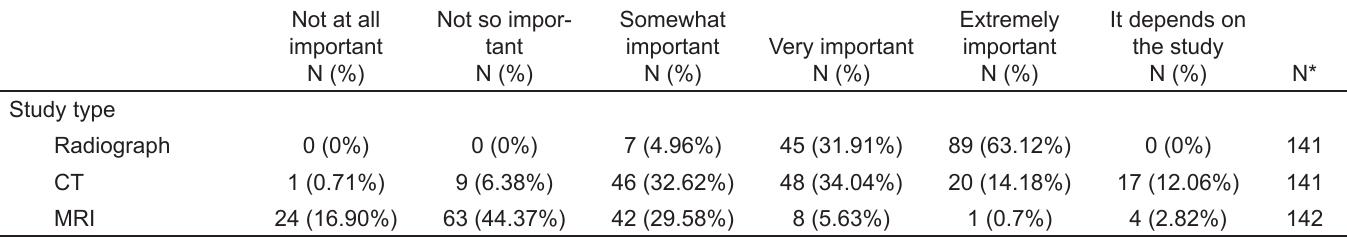
Table 3. Perceived importance of emergency care providers’ ability to independently interpret different radiology studies.